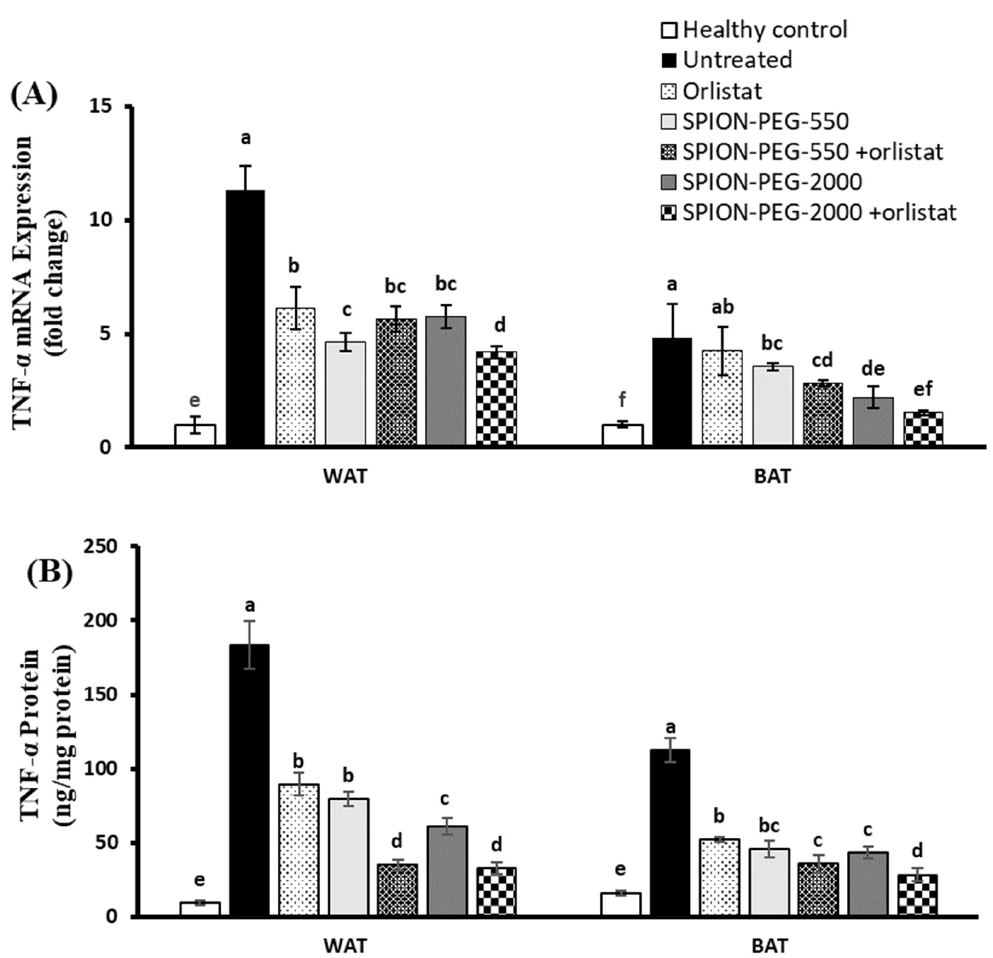
Figure 5. TNF- α expression in white and brown adipose tissues at mRNA ( A ) and protein ( B ) levels in control rats and obese rats untreated or treated with SPIONs and/or orlistat. Data presented as mean ± SD, and n = 8. Groups were compared at p < 0.05 using one-way ANOVA and Tukey post hoc test, and those which are not assigned with a shared letter (a–f) are statistically significant.